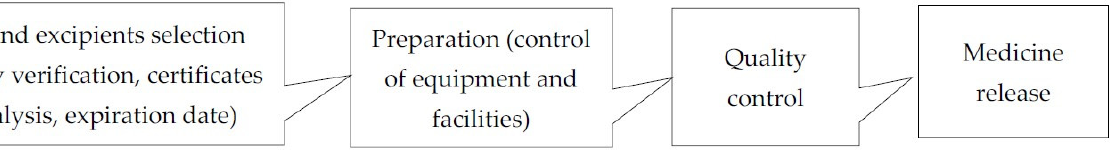
Figure 2. Main elements of the QAS in compounding pharmacies.